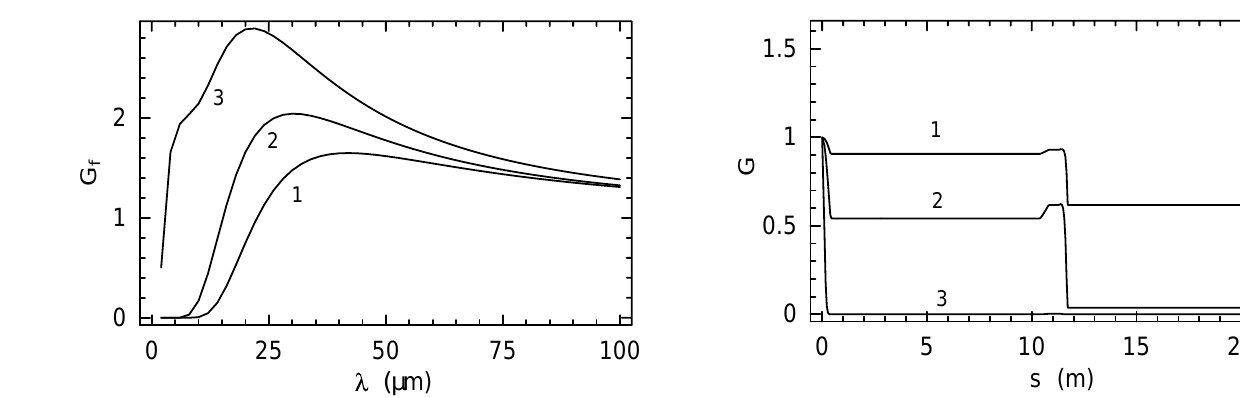
FIG. 3. Amplification factor G f as a function of wave- length l of the perturbation at the compressor entrance for various beam emittance and energy spread: ( 1 ) s p (cid:1) 3.0 3 10 2 5 , e (cid:1) 1 m m; ( 2 ) s p (cid:1) 3.0 3 10 2 5 , e (cid:1) 0 ; and ( 3 ) s p (cid:1) 3.0 3 10 2 6 , e (cid:1) 1 m m.